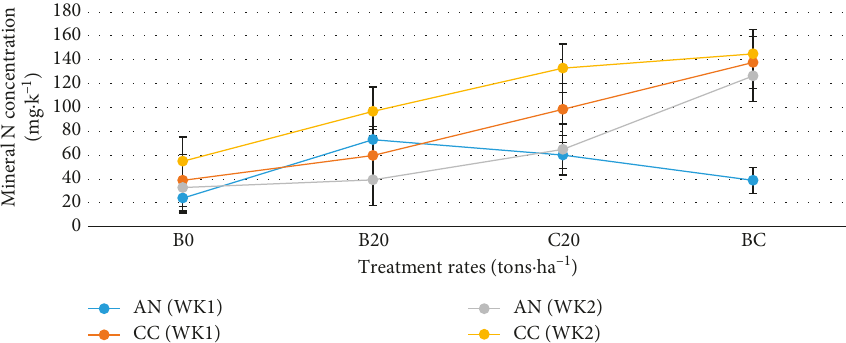
Figure 4: Soil mineral nitrogen concentration in Aiyinase and Cape Coast soils following application of biochar and/or compost 14 days after incubation. B0 � control with no amendments; B20 � biochar 2%, w/w; C20 � compost 2%, w/w; BC � combined biochar and compost